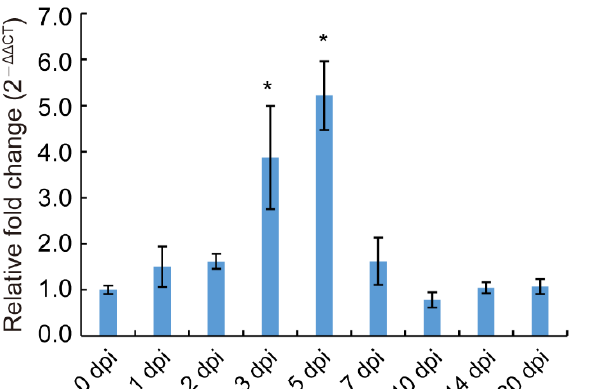
Figure 4. Expression pattern of UvSTE50 during the infection process of U. virens . The expression level of UvSTE50 relative to β‐ TUBULIN gene at different infection stages on inoculated spikelets (0 to 30 days) were tested by RT ‐ qPCR. Error bars represent SD. * represent significant differences compared with 0 dpi, as estimated by Duncan’s new multiple range test ( p < 0.05).